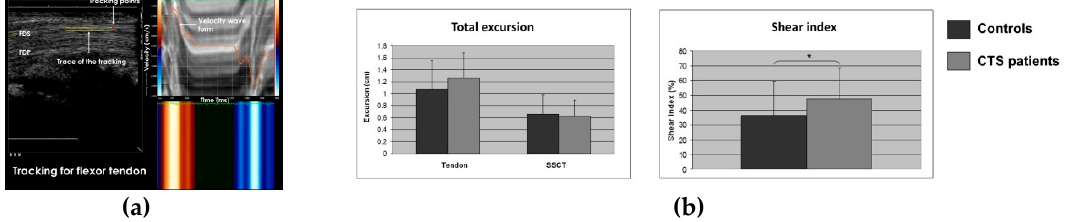
Figure 6. Speckle tracking ultrasound for the assessment of CTS. ( a ) An example image of speckle tracking, ( b ) tendon and subsynovial connective tissue excursions, and shear index. Reprinted from [79,80].